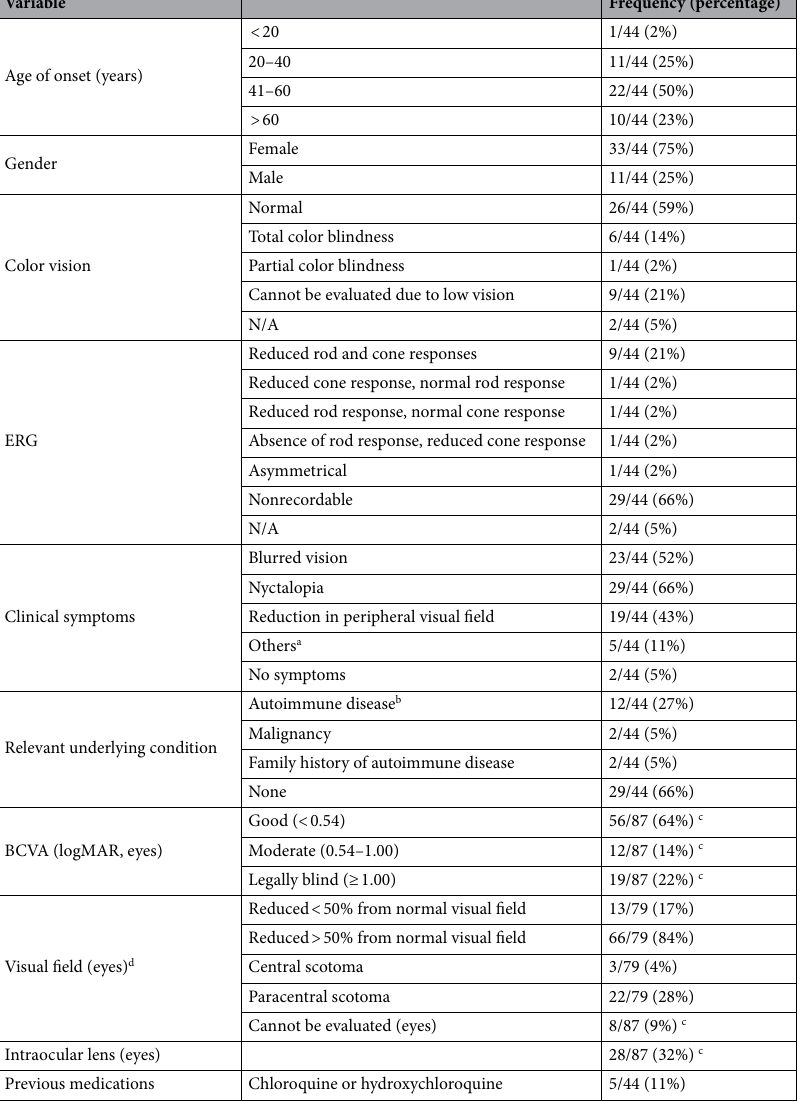
Table 1. Baseline characteristics of the suspected AIR patients. BCVA best corrected visual acuity, N/A not applicable. a Photoaversion, photosensitivity, photopsia, hemeralopia, eye pain, dry eye. b Systemic lupus erythematosus (SLE), rheumatoid arthritis (RA), pemphigus vulgaris, minimal change disease (MCD), undifferentiated connective tissue disease (UCTD). c One patient had one prosthetic eye. d There were two patients without VF data and five patients with VF data only in one